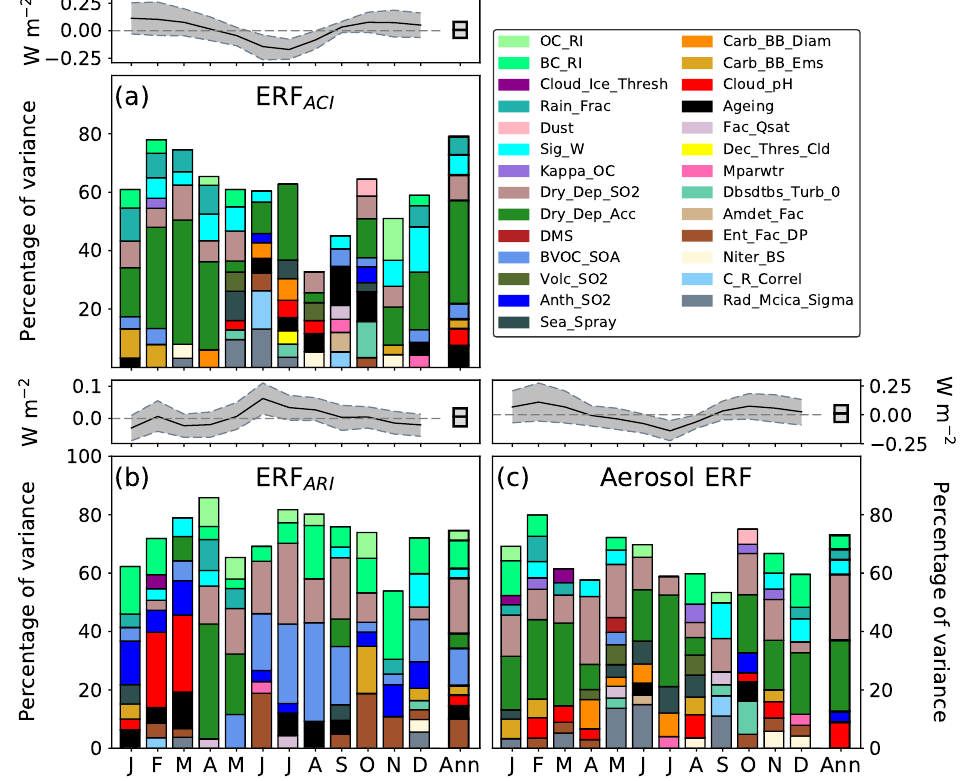
Figure 6. Percentage contributions to variance in 1978–2008 global, monthly and annual mean (a) ERF ACI , (b) ERF ARI and (c) aerosol ERF. Figure features are identical to Fig.